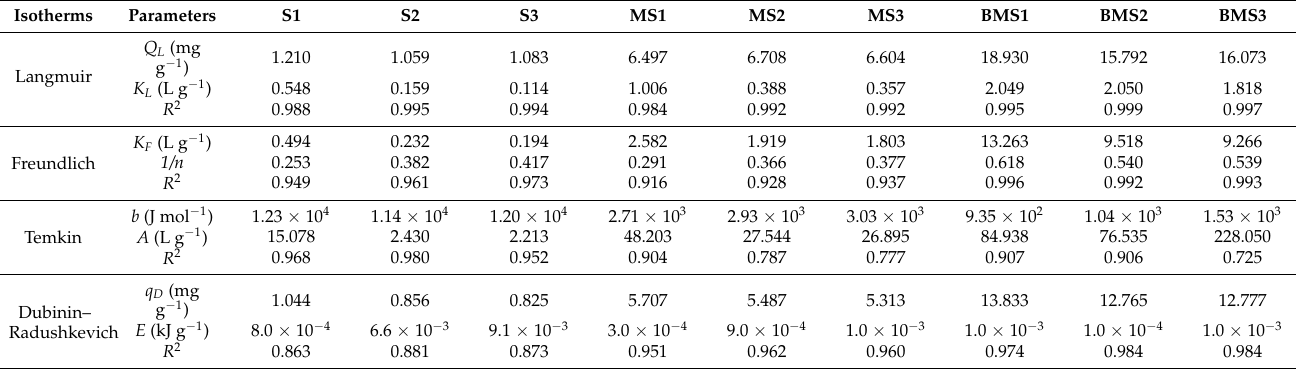
Table 5. Parameters obtained from nonlinear isotherm models for doxycycline sorption onto different soils (pH 7.41 (S1), pH 8.32 (S2), and pH 8.48 (S3)), manure + S1 (MS1), manure + S2 (MS2), manure + S3 (MS3), mesquite wood-waste-derived biochar + MS1 (BMS1), mesquite wood-waste-derived biochar + MS2 (BMS2), and mesquite wood-waste-derived biochar + MS3